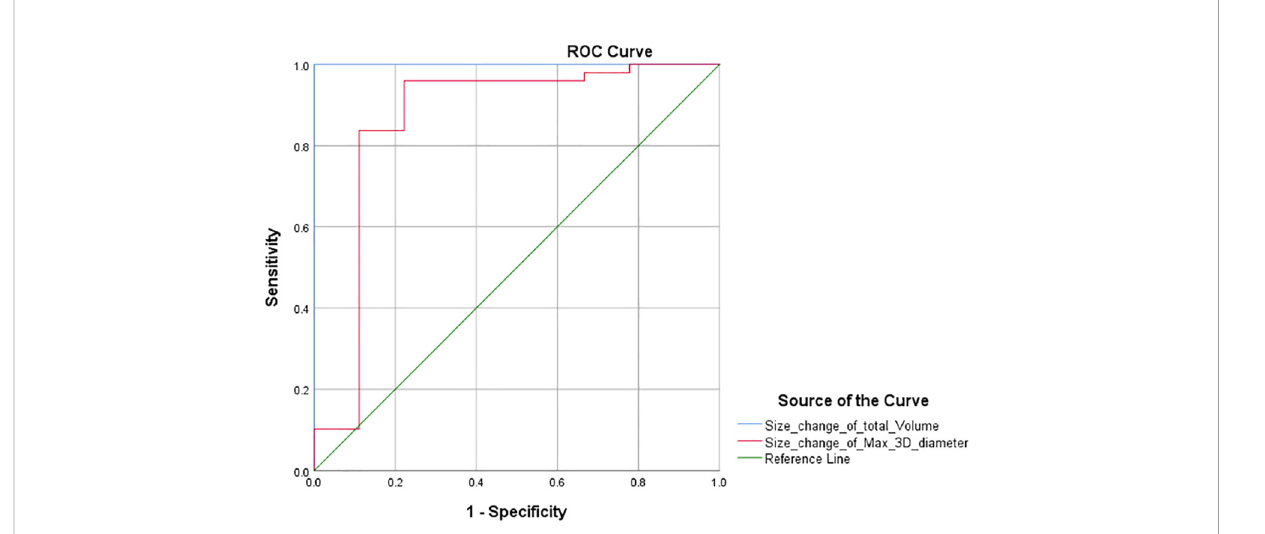
FIGURE 3 ROC curve with PR threshold as